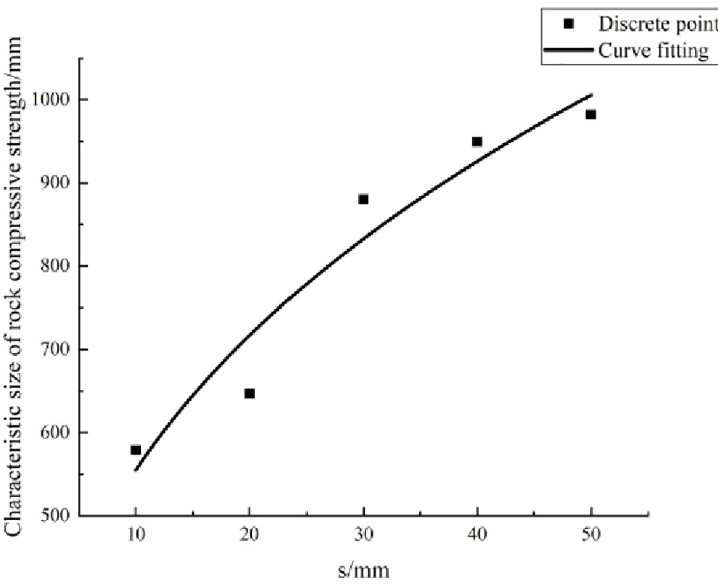
Fig 10. Fitting curve of uniaxial compression characteristic size and parallel-joint